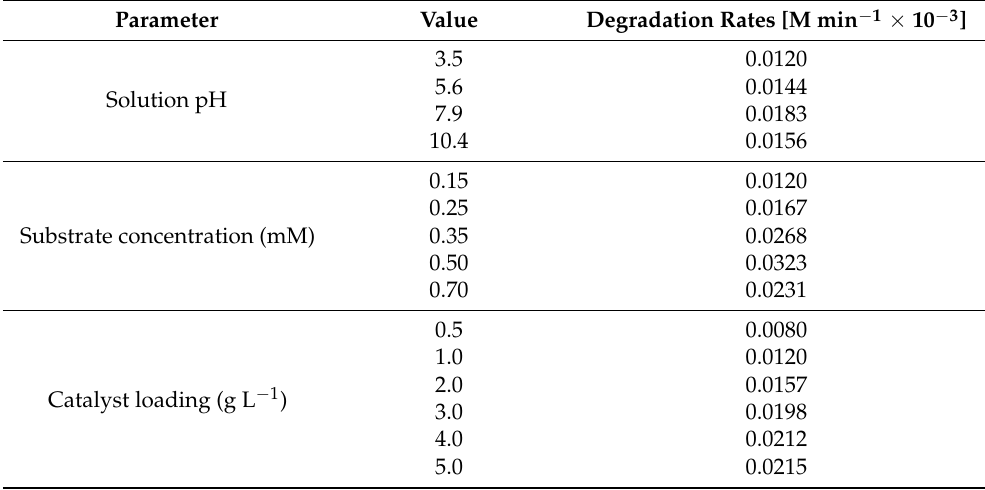
Table 2. Photocatalytic degradation of amaranth in aqueous suspensions under different experimen- tal